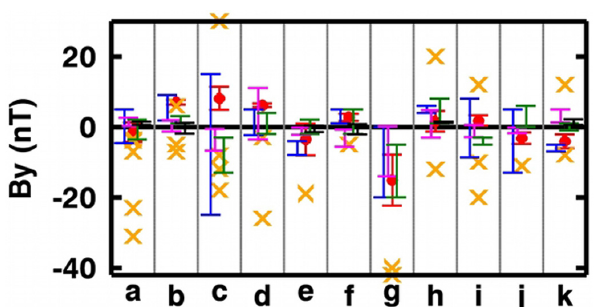
Fig. 8. The range of guide field values for reconnection process en- counters a–k, found using four different methods (when applicable). The average 3h IMF B y (red dots and error bars) and the maximum core field measured for each flux rope (yellow crosses) are added for comparison. Method 1: blue, method 2: magenta, method 3: green and method 4: